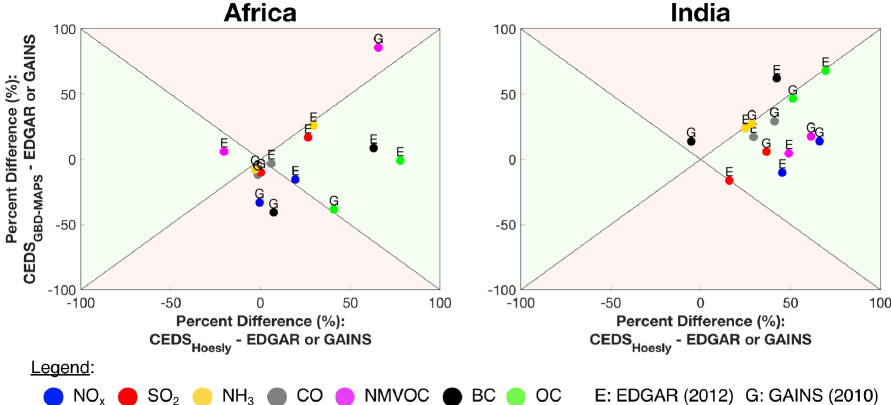
Figure 4. The x and y axes show the percent difference between CEDS emissions in India and Africa ( y axis: CEDS GBD-MAPS ; x axis: CEDS Hoesly ) and those from the GAINS (ECLIPSE v5a) and EDGAR v4.3.2 inventories (i.e., 100 × (CEDS − EDGAR) / ((CEDS − EDGAR) / 2)). Comparisons are conducted with the most recent available year, 2010, for the comparison with GAINS and 2012 for the com- parison with EDGAR. Green regions indicate where the CEDS GBD-MAPS emissions have improved agreement with EDGAR and GAINS relative to the CEDS Hoesly inventory. Red regions indicate where CEDS GBD-MAPS emissions have worse agreement with EDGAR or GAINS relative to the CEDS Hoesly inventory. The color of each point represents the chemical compound, and each point is labeled with an “E” or “G”, indicating that the percent difference was calculated using EDGAR or GAINS, respectively.